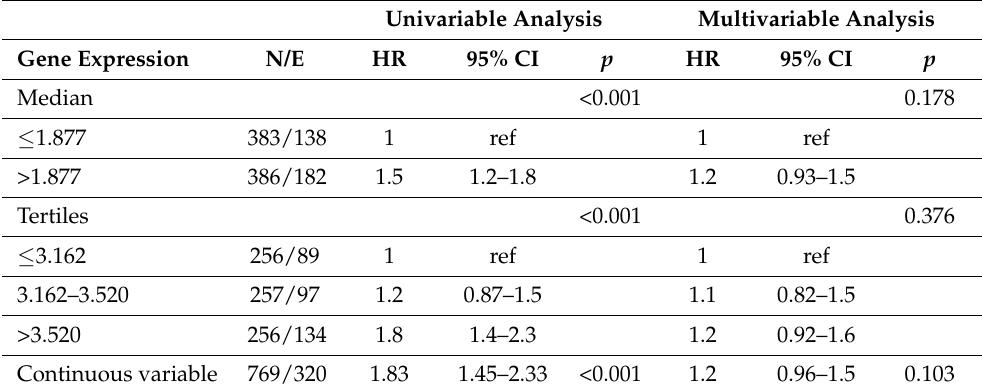
Table 7. Event Free Survival of 769 NB patients in relation to TSSC1 expression levels evaluated by the Cox model.